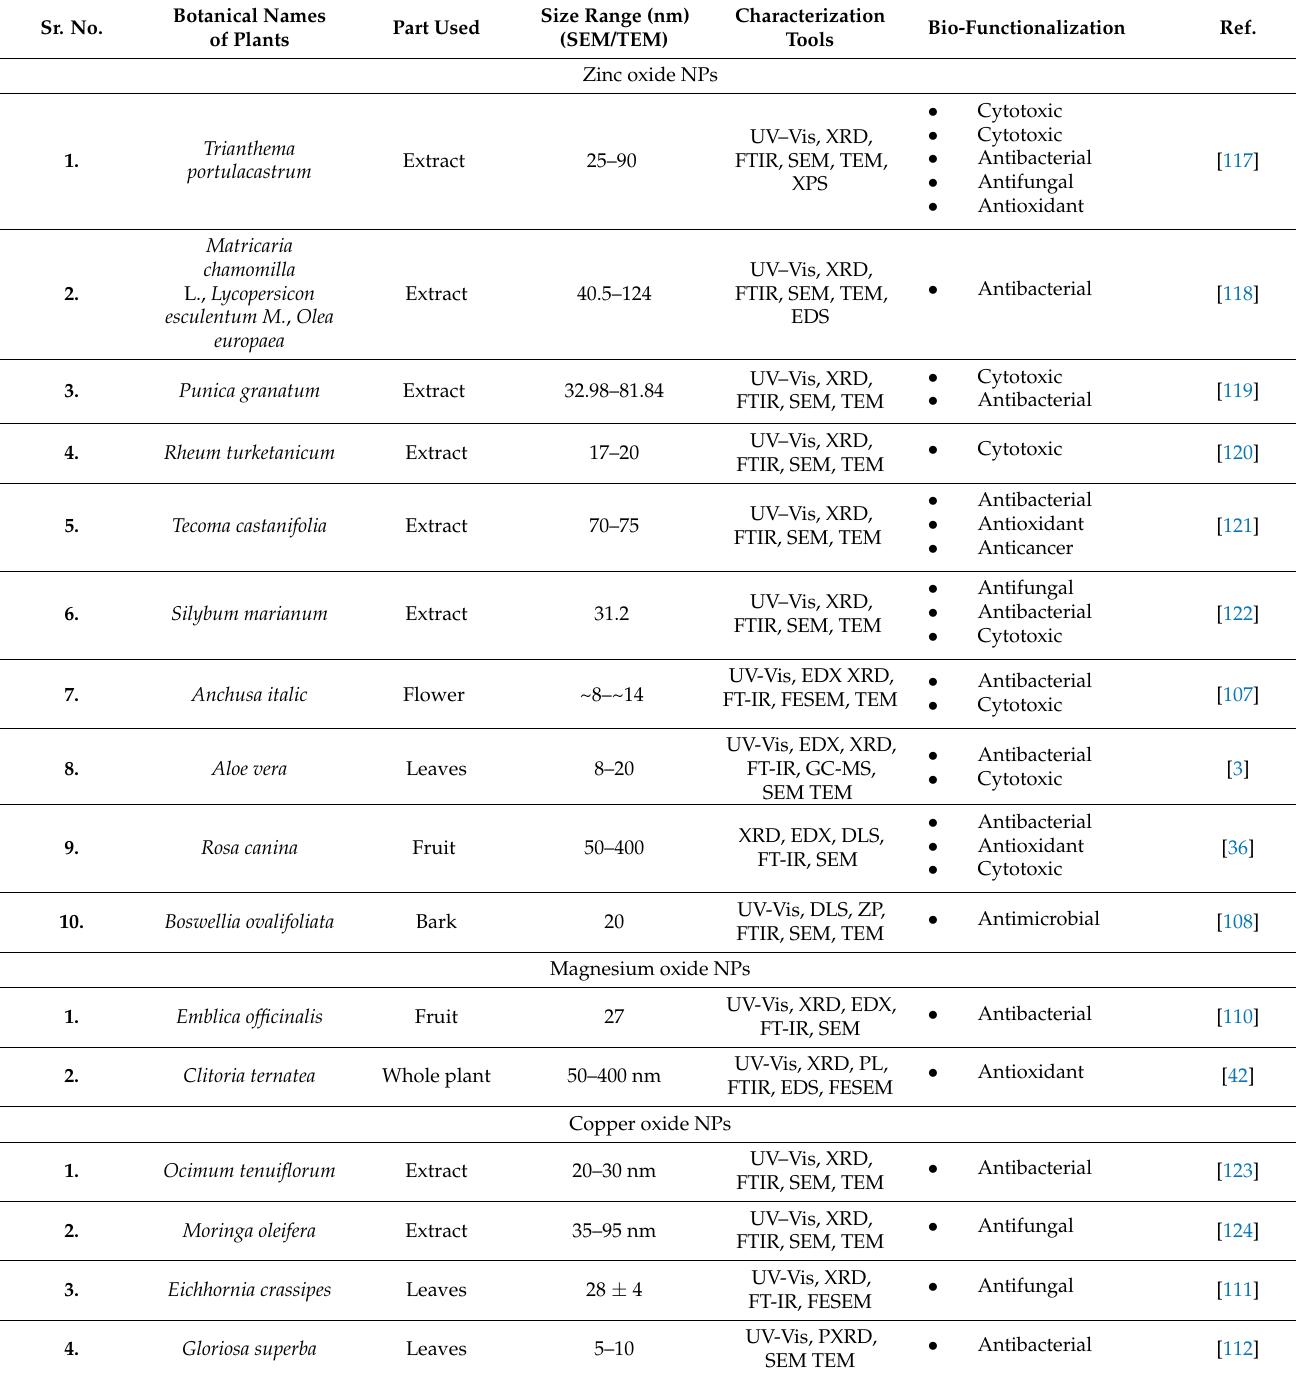
Table 5. Bio-reduction of other metal oxides NPs and their